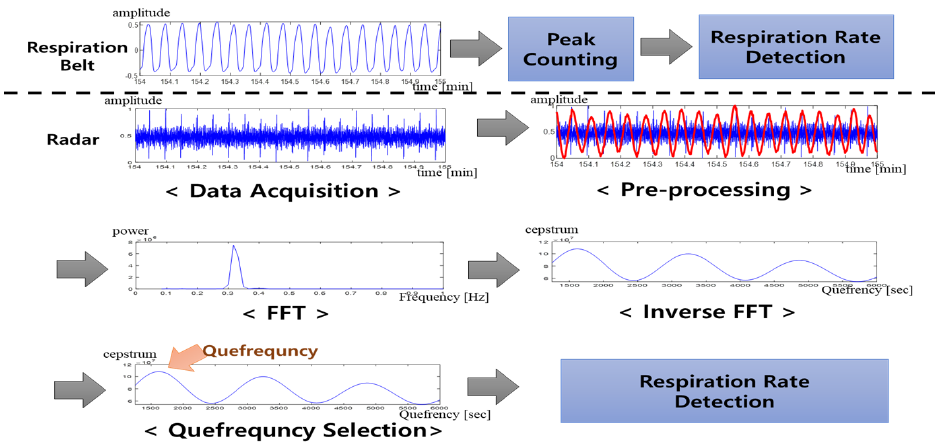
Figure 3. Overview of the respiration rate detection. FFT: Fast Fourier transform.